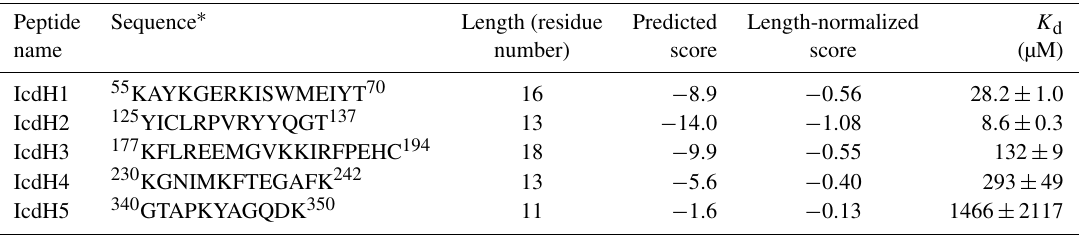
Table 1. List of ICDH-derived peptides and their properties associated with TF binding. Peptide Sequence ∗ Length (residue Predicted Length-normalized K d name